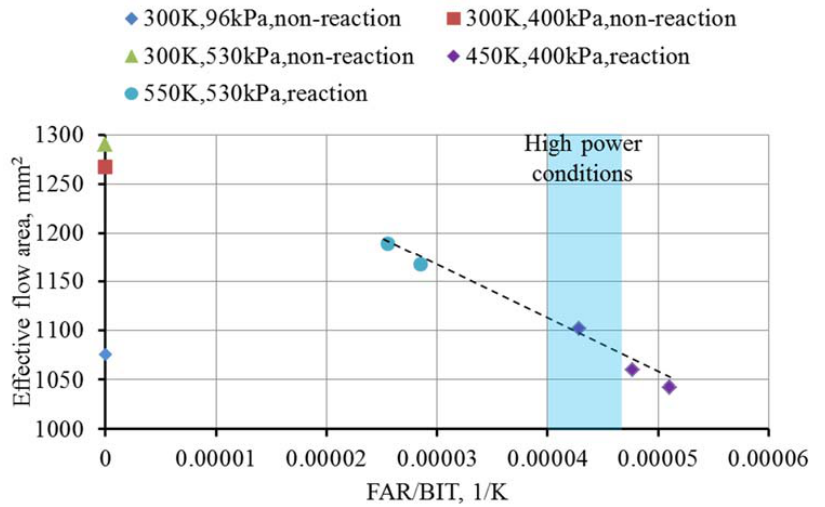
Figure 12. Compare of effective flow areas under different conditions.